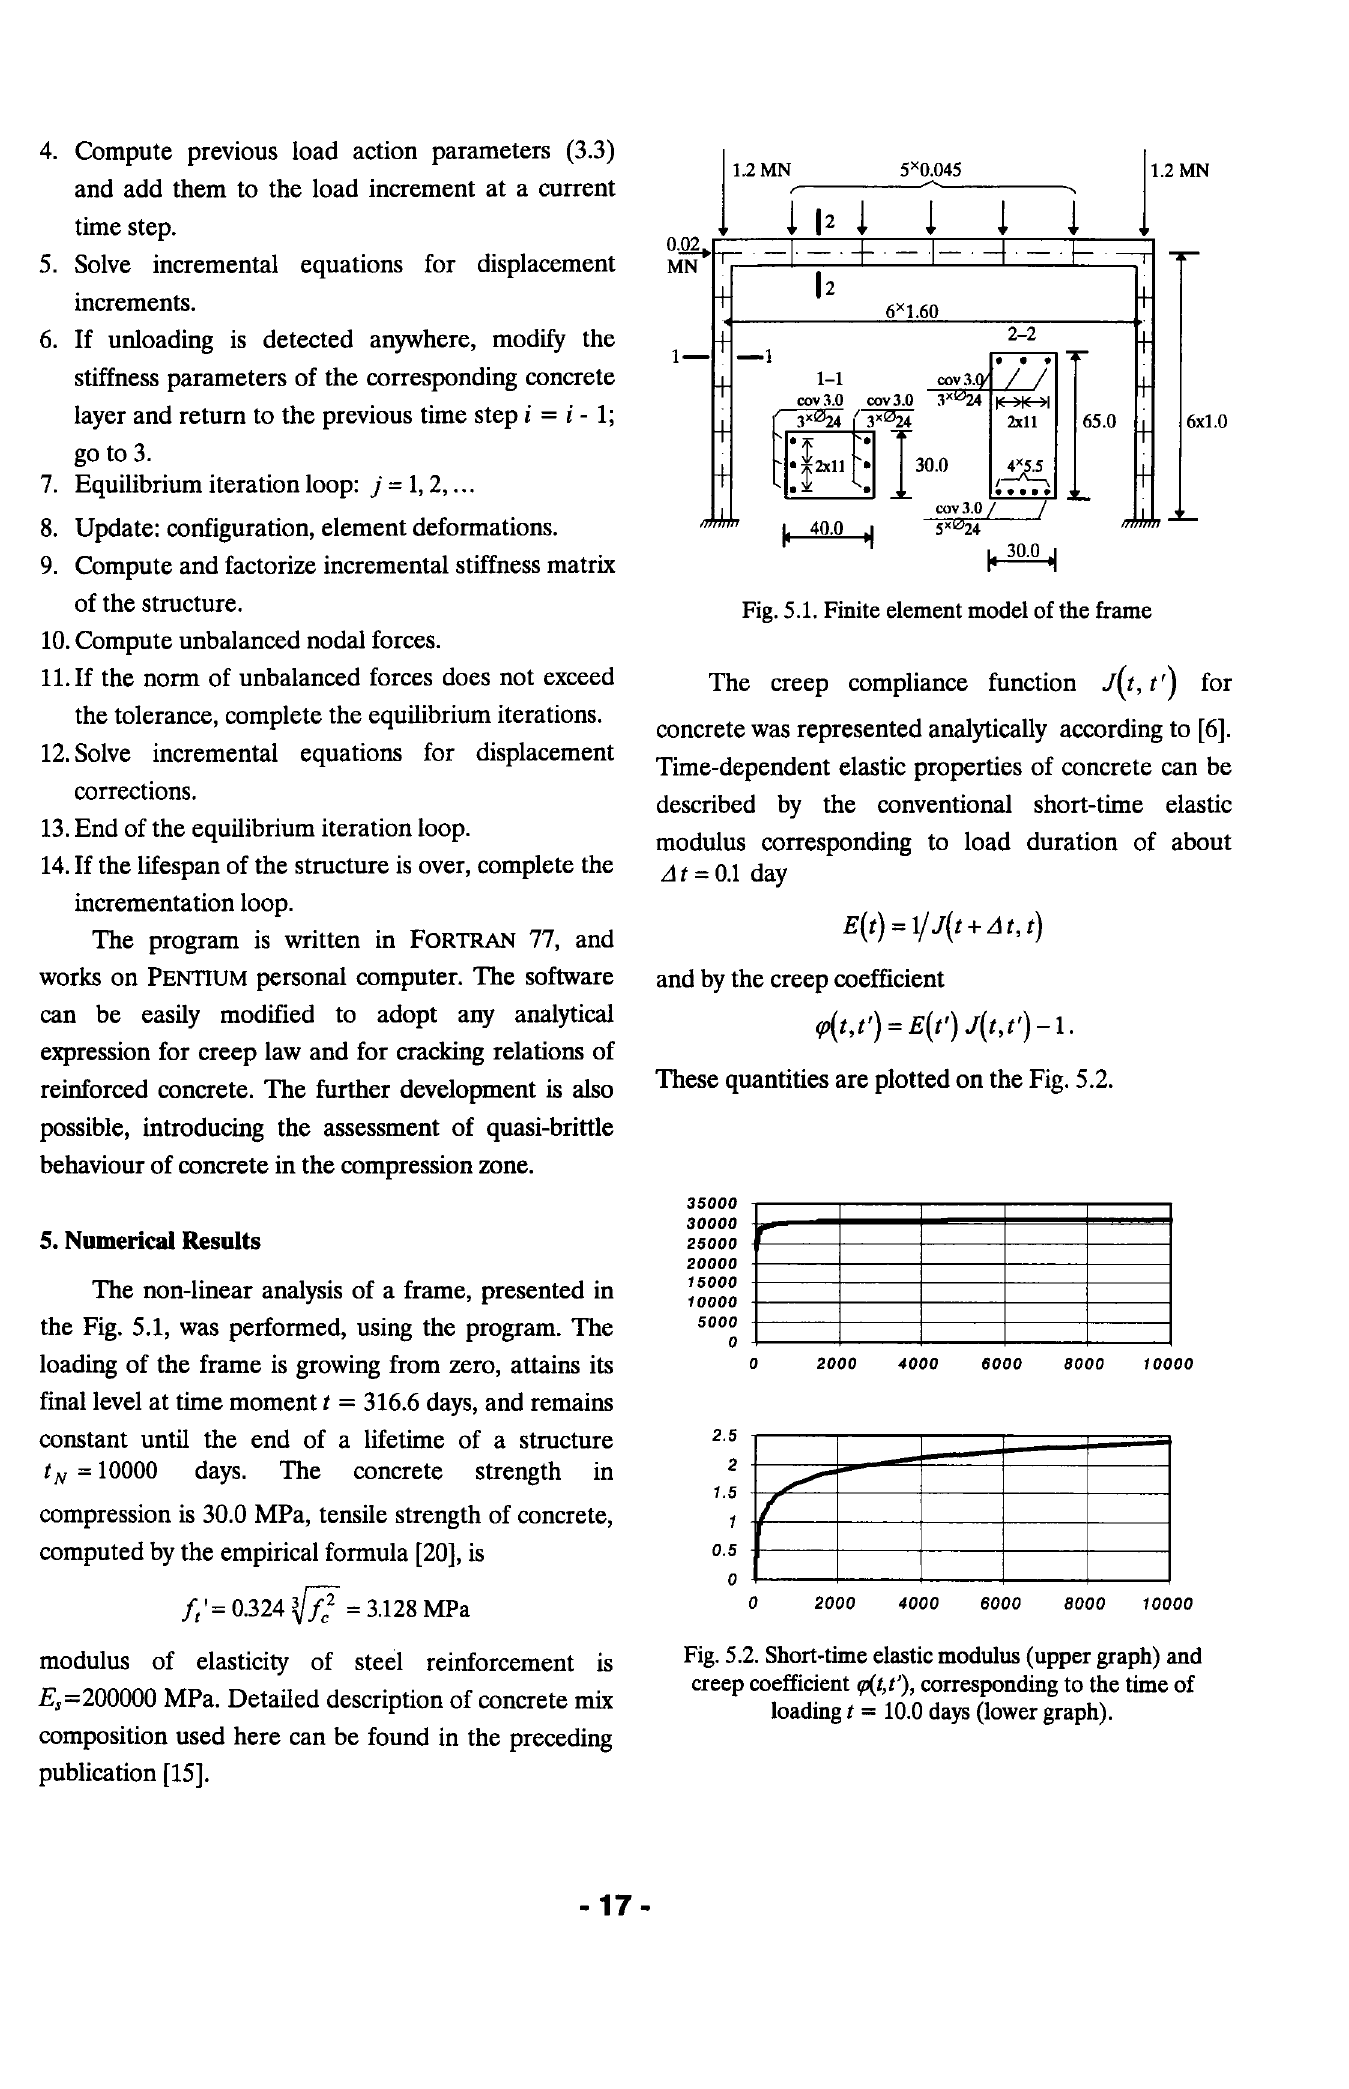
Fig. 5.1. Finite element model of the frame The creep compliance function J(t, t') for concrete was represented analytically according to [6].